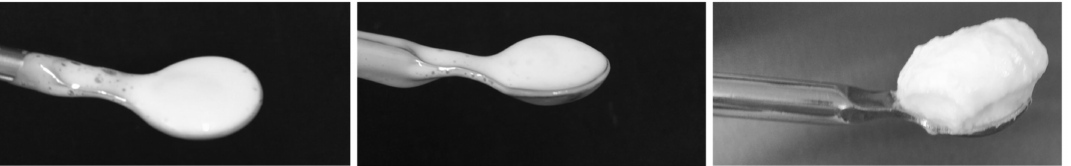
Figure 6. Double emulsions with comparable formulation but di ff erent initial W1 fractions. The W1 phase is hypotonic, leading to osmotic swelling of the W1 droplets. The e ff ect of osmotic swelling on double emulsion viscosity is more pronounced (higher viscosity) when the initial W1 fraction is higher. W1 / O / W2 phase composition: W1: aqueous 0.35 wt % NaCl solution; O: canola oil with PGPR; W2: aqueous polyvinyl alcohol solution. Left to right: 30%, 50%, and 70% of initial inner water phase.